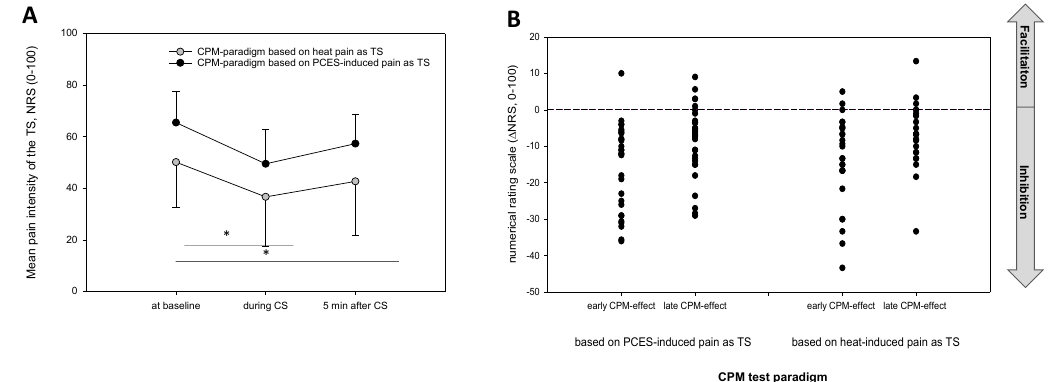
Figure 3. ( A ) Comparison of the pain intensity between the conditioned pain modulation paradigm using painful cutaneous electrical stimulation (PCES) and heat pain as test stimulus (mean ± SD; numerical rating scale (NRS) 0–100, 0 = no pain and 100 = strongest pain imaginable). * significance p -value below the level of significance ( B ) Individual early (di ff erence between values during conditioning stimulus (CS) and values at baseline) and late conditioned pain modulation (CPM)-e ff ects (di ff erence between values after CS and values at baseline) based on both testing paradigms, negative values indicating endogenous pain